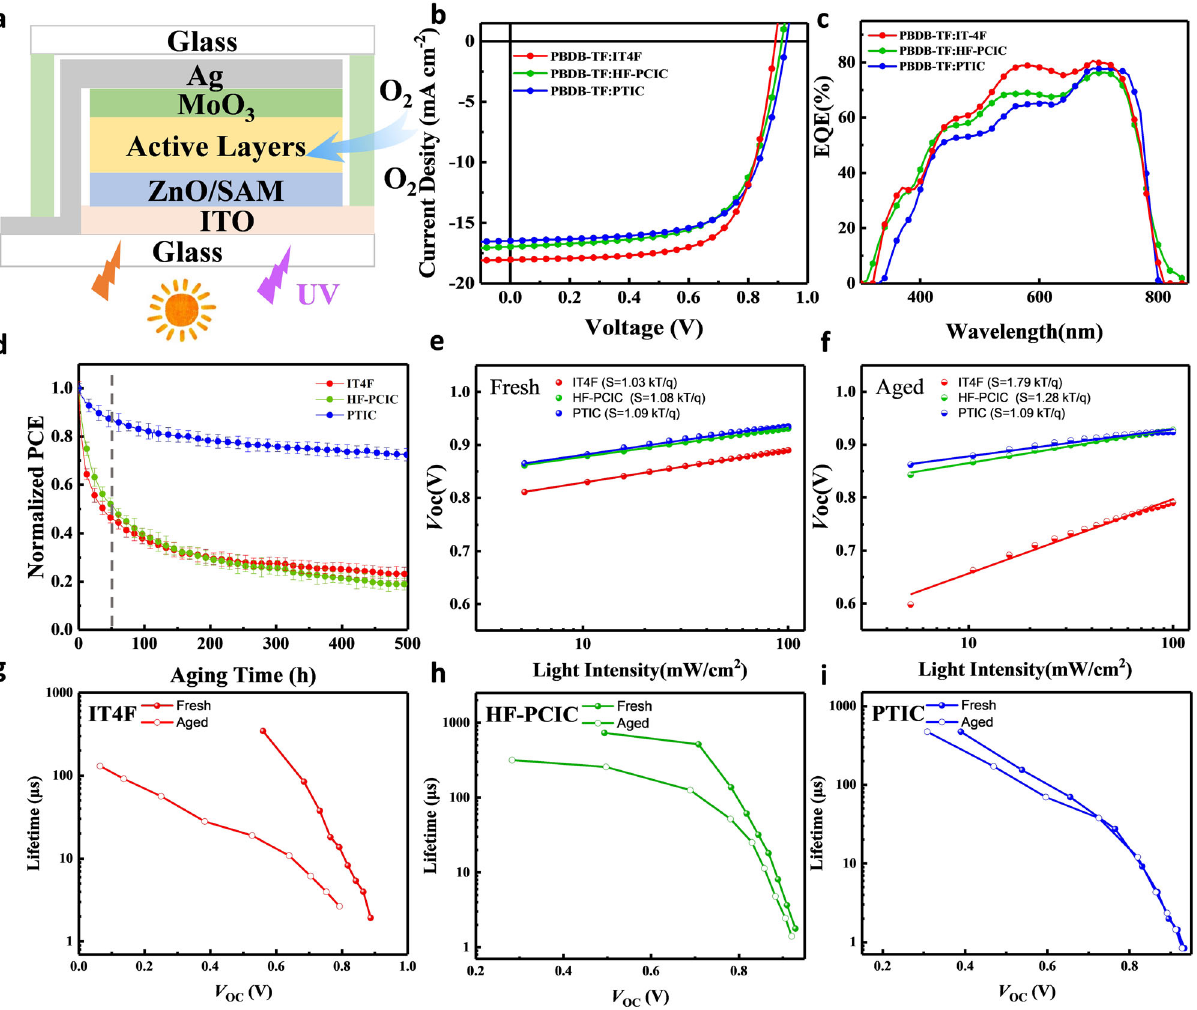
Fig. 7 Photostability of NFOSCs. a Schematic illustration of inverted OSCs tested in ambient without UV fi lter. b The J – V characteristics and c , EQE spectra of OSCs under AM 1.5 G illumination (100 mW cm − 2 ). d Stabilities of OSCs under continuous one-sun-equivalent illumination (the gray line indicates the fi rst 50 h of illumination, and the error bars represent the standard deviation from four devices). V oc versus light intensity of e , fresh devices and f , aged devices for 50 h illumination. g – i Charge carrier lifetime as a function of V oc in fresh and aged devices for 50 h illumination based on IT-4F, HF-PCIC, and